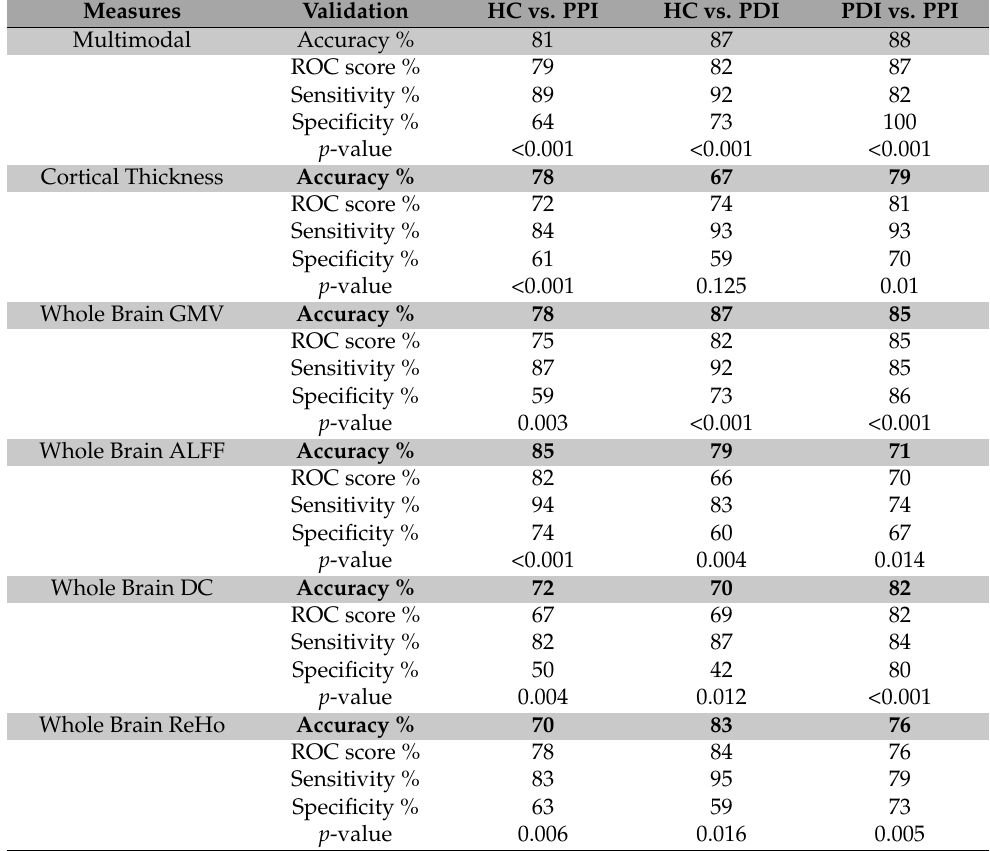
Table 1. Outcomes of unimodal and multimodal